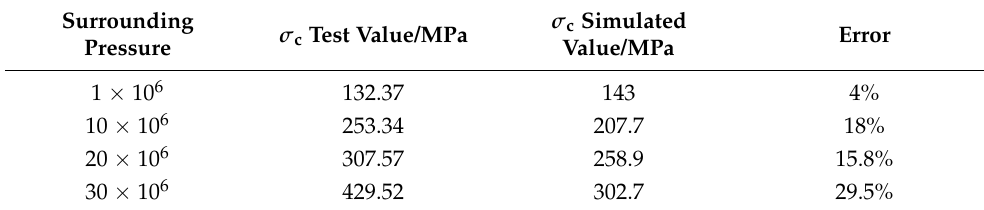
Table 3. Calculation results of compressive strength of biaxial